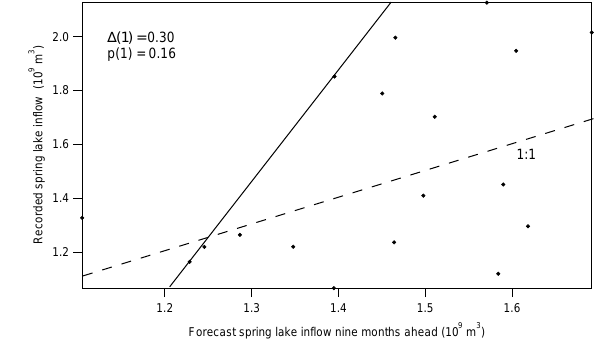
Fig. 1. Scatter plot of October Rainfall values (1951–1987) at Berurim in southern Israel. Line shows the linear internal bound- ary of the largest possible data-sparse region for m = 1.